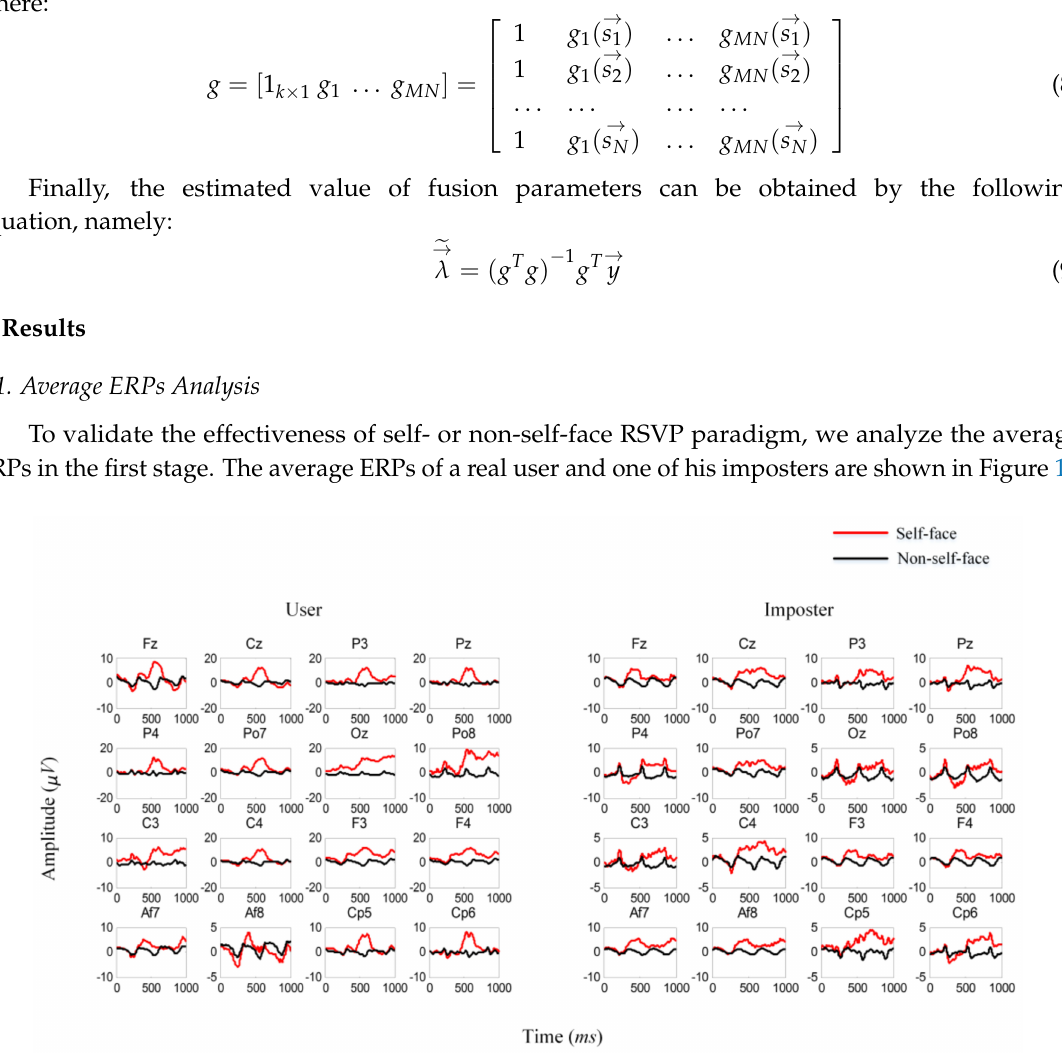
Figure 12. Average ERPs evoked by the self-face (red line) and non-self-face (black line)